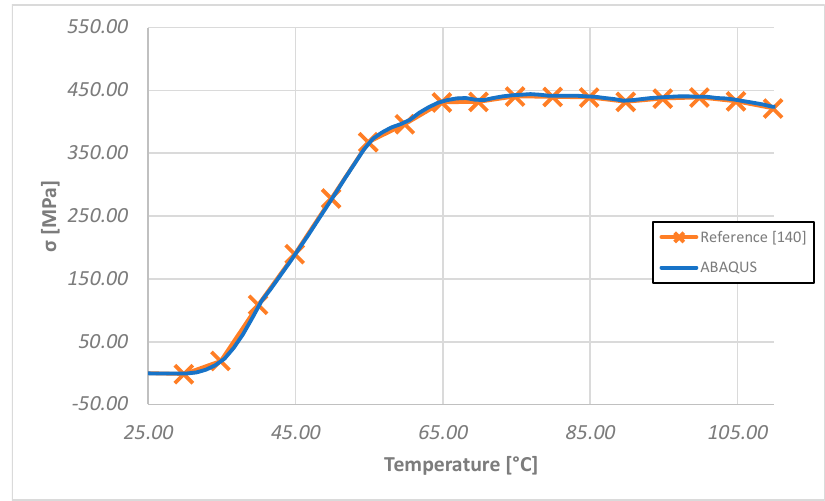
Figure 6. Numerical test results [140].